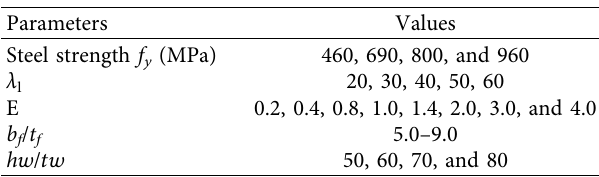
Figure 4: Comparison of test and FE model load-lateral deflection curves: (a) EH1P [19]; (b) EH2P [19]; (c) EH3P [19]; and (d) EH4P Table 3: Parameters of FE models.